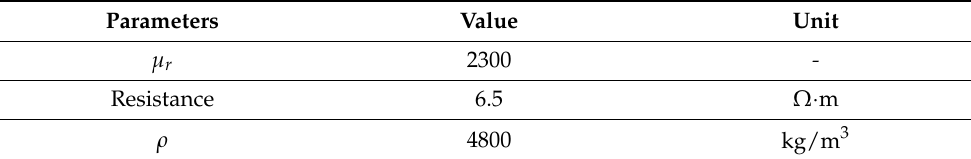
Table 3. Product features of PC40 provided by TDK Corporation.